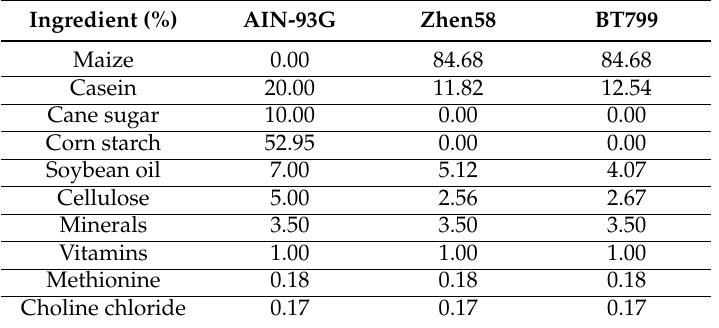
Table 1. Composition of diets for rats.